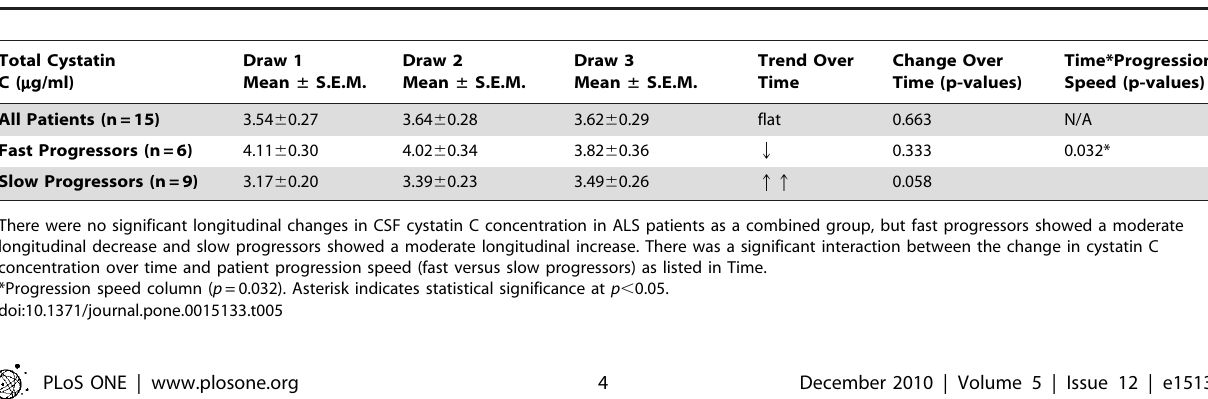
Table 5. Repeated measures tests for the change in total cystatin C concentration over time.